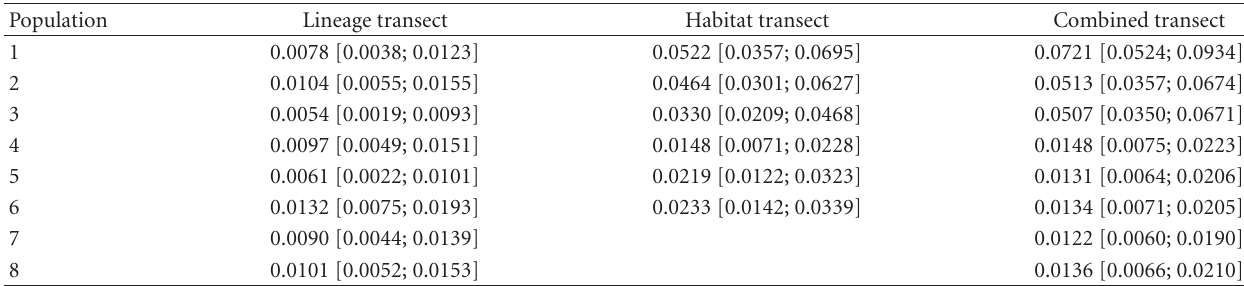
Table 1: Bayesian estimates of Fst values for each population. The mean value and the lower and upper limits of the 95% highest probability density interval are indicated. These Fst values measure the di ff erentiation of a given population relative to all other populations.